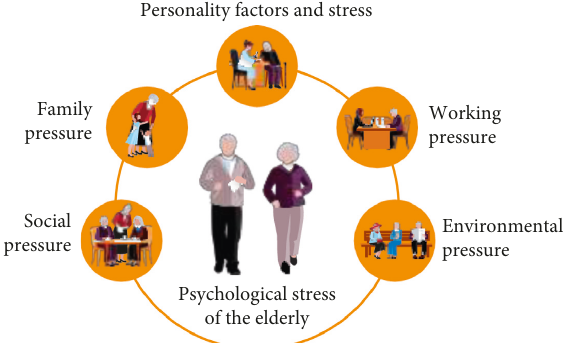
Figure 1: Psychological stress